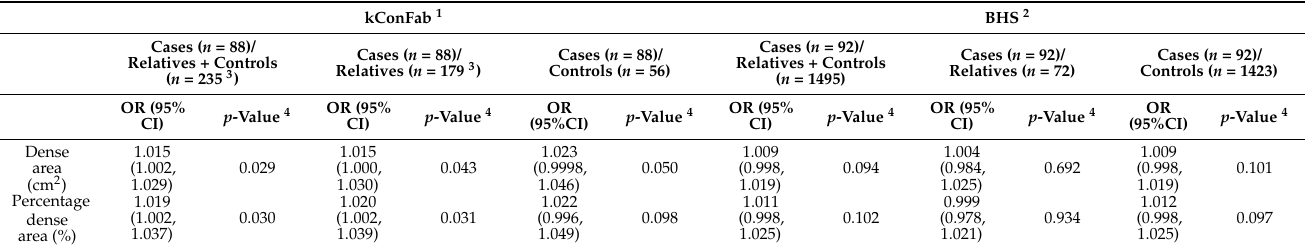
Table 2. Logistic regression estimates (odds ratios (OR) and 95% confidence intervals (CI)) showing the associations between MBD measures and breast cancer risk for both the kConFab and BHS studies.